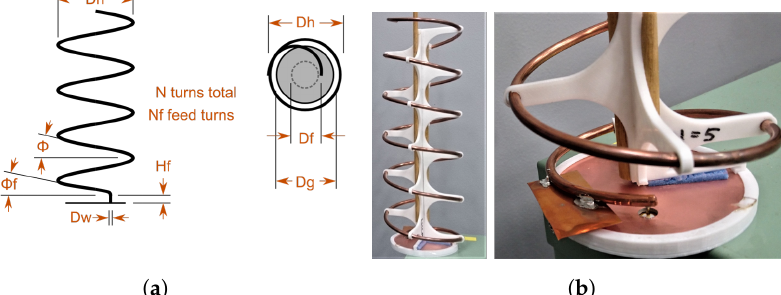
Figure 4. ( a ) Side and top view of backfire helix antenna; and ( b ) constructed helix and wavetrap used for impedance